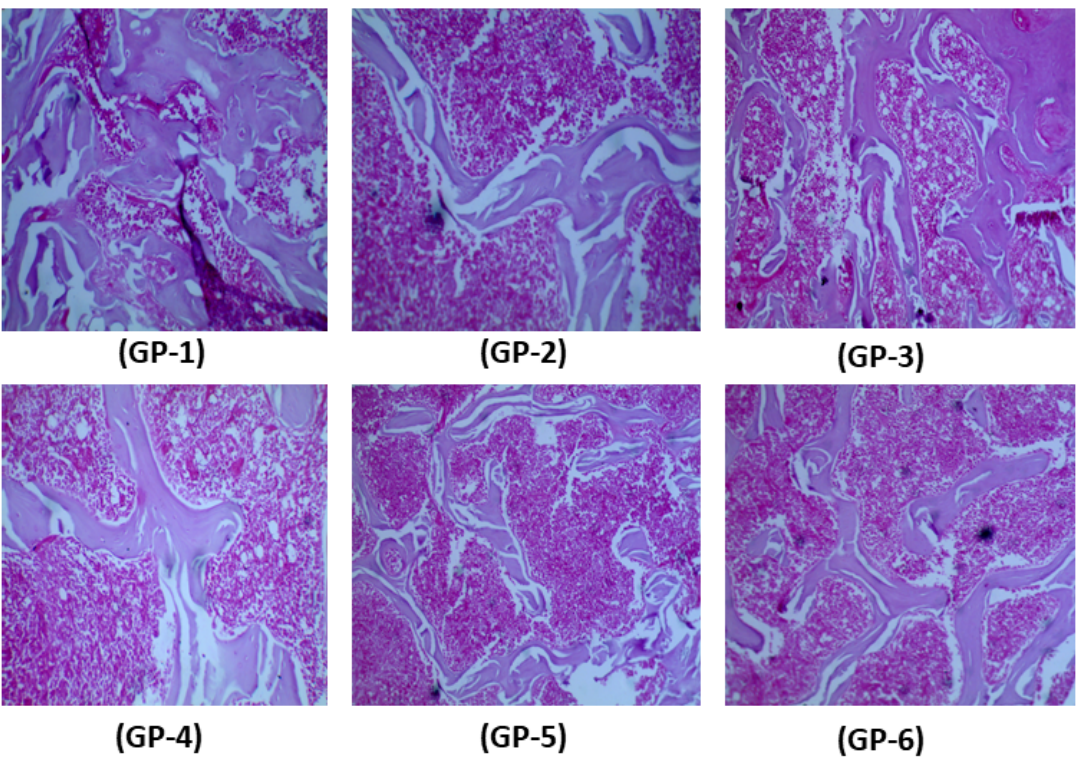
Figure 3. Histopathological changes in bone among group fed on vitamin D deficient diet (GP-1), shiitake (GP-2), button (GP-3), oyster (GP-4), vitamin D 2 (GP-5) and vitamin D 3 (GP-6).